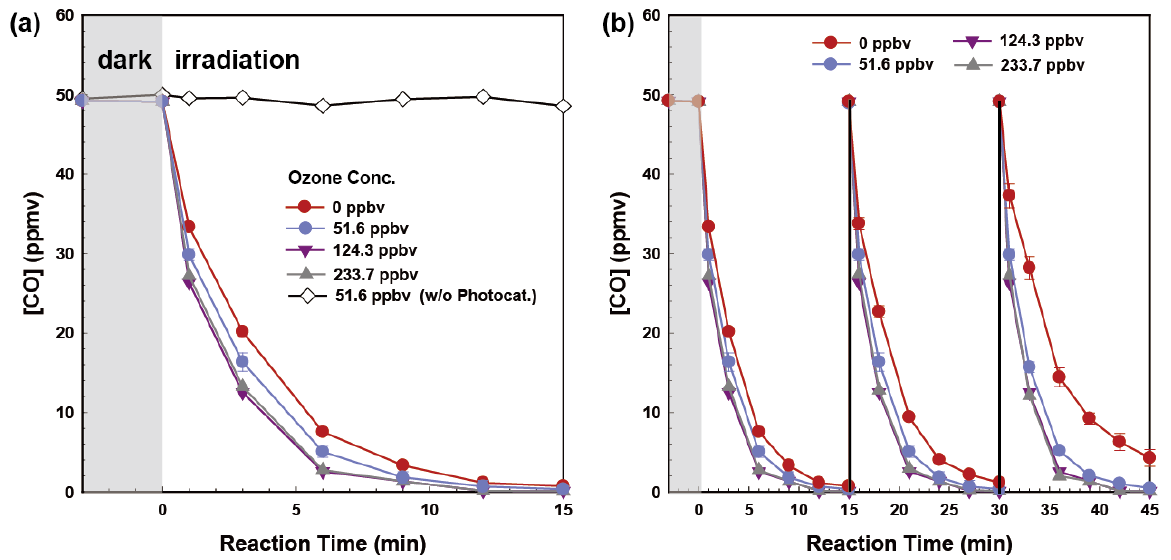
Figure 5. ( a ) Time-dependent profiles of photocatalytic oxidation of CO on Pt/facet-engineered TiO 2 in several different initial ozone concentrations. ( b ) Repeated photocatalytic oxidation cycles of CO on Pt/facet-engineered TiO 2 in several different initial ozone concentrations.